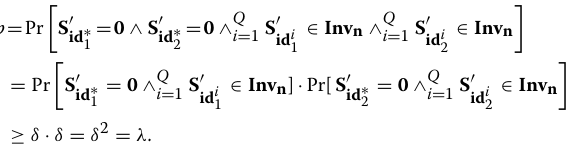
abort the game as in Game 4 . Otherwise, A id ∗